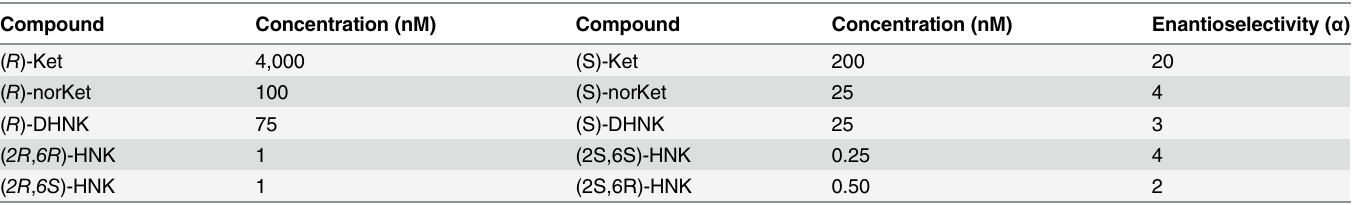
Table 3. The minimum concentration (nM) of ketamine (Ket) and Ket metabolites required to elicit maximum increase in the expression of the monomeric form of SR (m-SR) in PC-12 cells. The effect of the configuration at the chiral centers at saturating concentration of each compound is repre- sented as the enantioselectivity factor α derived from Concentration(2R isomer)/Concentration(2S isomer). The values for (R)-Ket and (S)-Ket were obtained from [17].